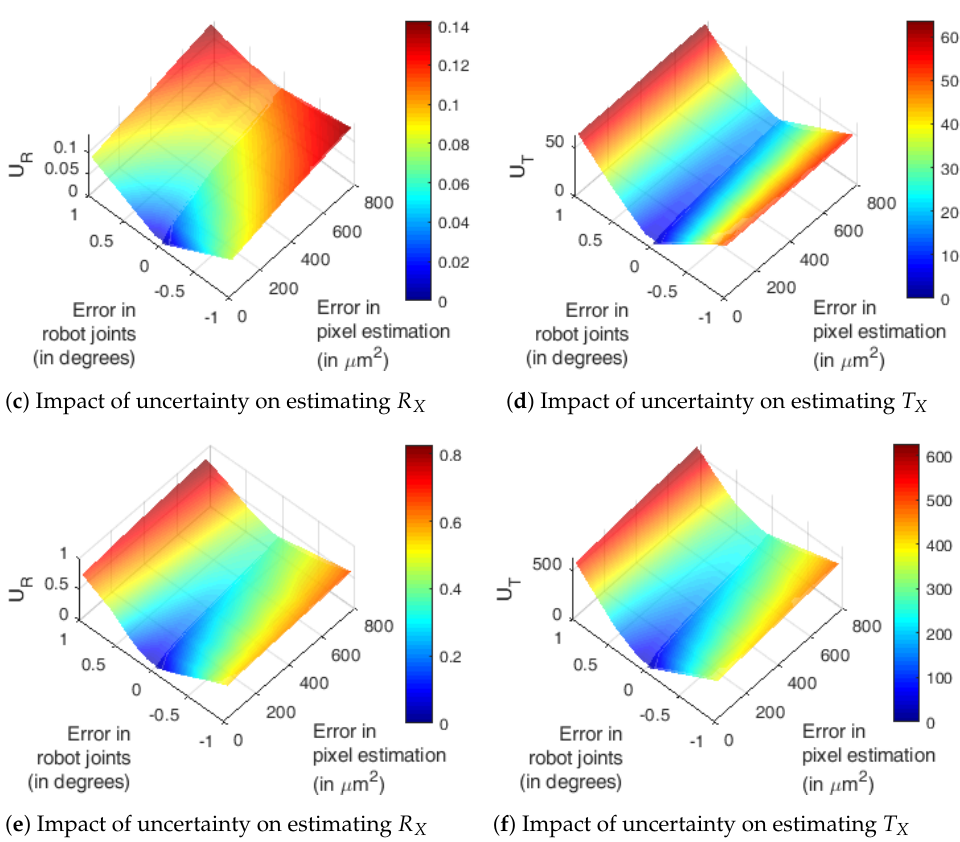
Figure 5. Error norms associated with rotation matrix and translation vector estimated using: ( a , b ) Horaud–Dornaika method; ( c , d ) Tsai–Lenz method; ( e , f ) Andreff et al.